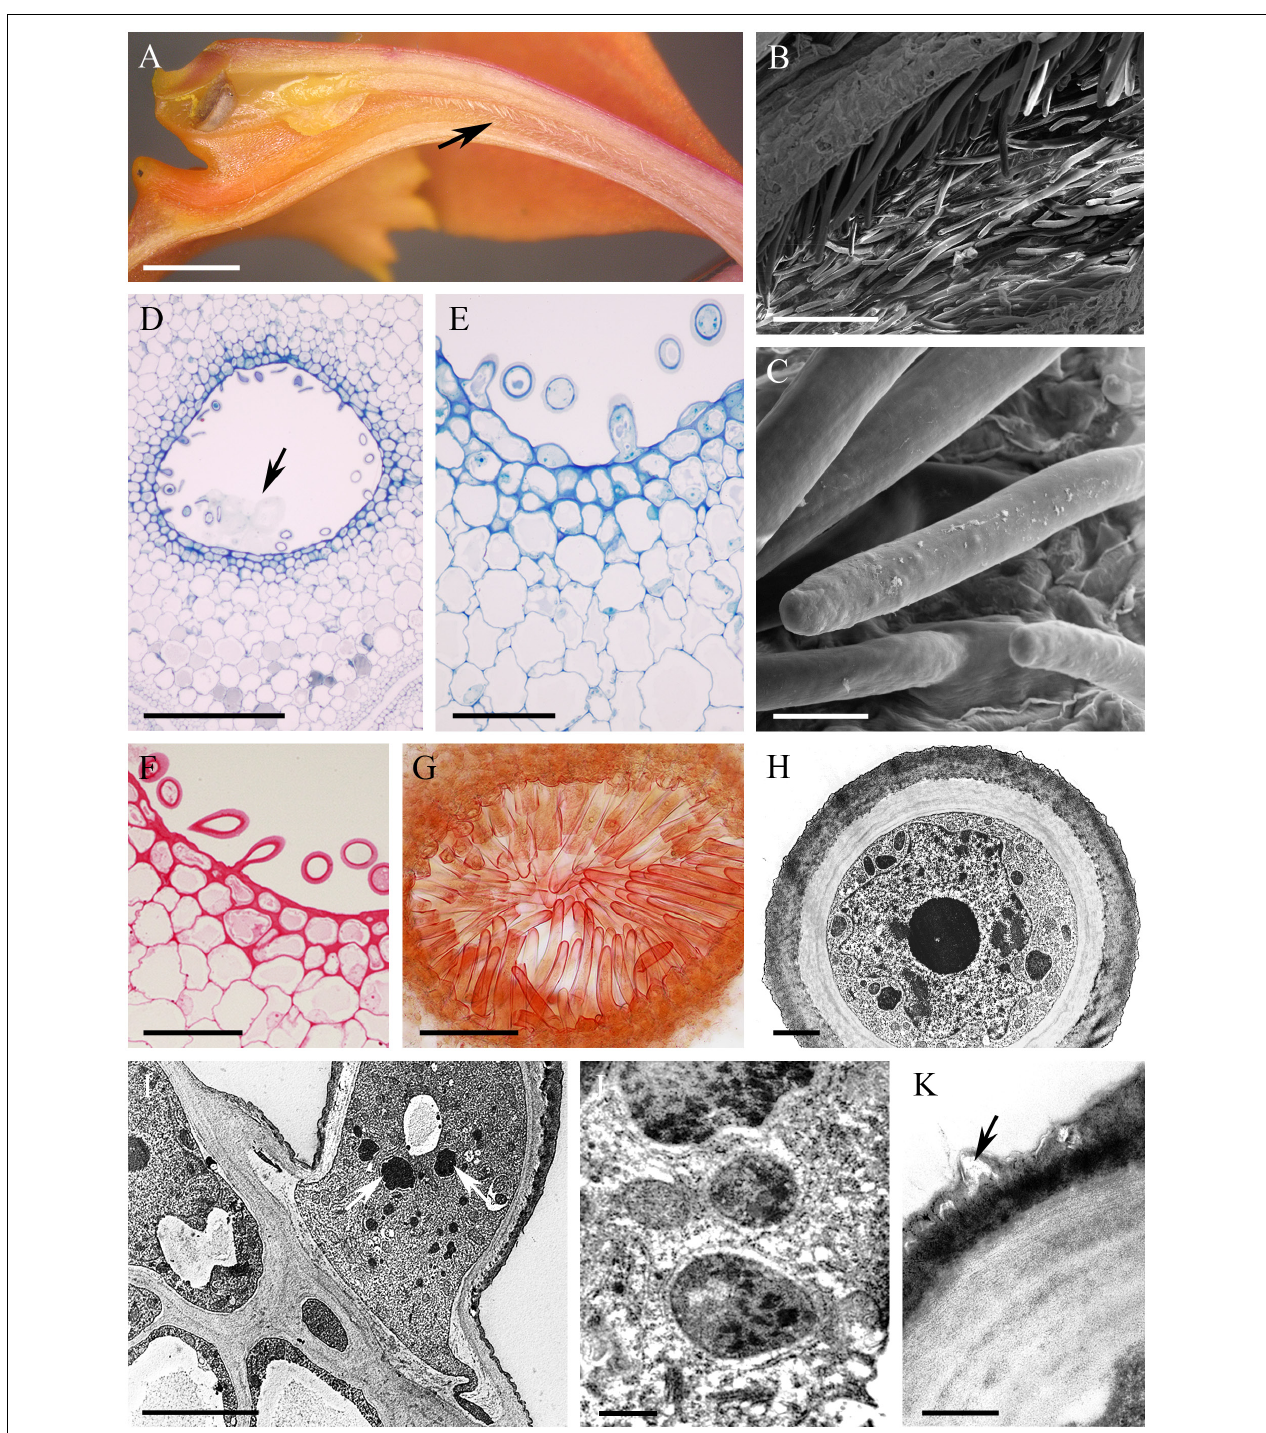
FIGURE 10 | Epidendrum radicans . (A) Longitudinal section of flower, the cuniculus indicated by an arrow. (B) Unicellular trichomes lining cuniculus. (C) Detail of smooth cuticle of trichomes with small blisters. (D) Tissues enclosing cuniculus. Secreted surface material is marked by arrow (MB/AII). (E) Detail of epidermis of cuniculus with trichomes and subepidermal tissues. (F) PAS reaction stains cellulosic cell walls. (G) Sudan III stains thick cuticle of trichomes. (H) Transverse section of trichome showing cell wall with thick, smooth, but slightly blistered cuticle and electron-dense protoplast enclosing large nucleus. (I) Longitudinal section through trichome, epidermal and subepidermal cells. Note electron-dense plastids (arrows) in trichome. (J) Detail of cytoplasm of trichome with starchless plastids, mitochondria, dictyosomes and ER. (K) Cell wall of trichome with blistered cuticle (arrow). Scale bars: A = 2 mm; B = 200 µ m; C = 20 µ m; D = 500 µ m; E,F = 50 µ m; G = 100 µ m; H = 2 µ m; I = 5 µ m; J,K = 0.5 µ